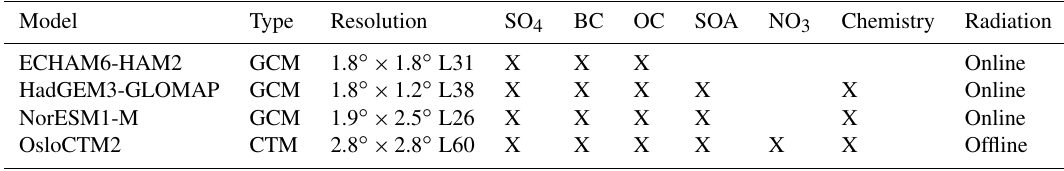
Table 2. List of models participating in the ECLIPSE radiative forcing simulations. Models are either general circulation models (GCM) or chemistry-transport models (CTM). Resolution indicates the horizontal resolution, in degrees, and the number of vertical levels. Crosses indicate which aerosol species are represented in each model, among sulfate (SO 4 ), black carbon (BC), organic carbon (OC), secondary organic aerosol (SOA), and nitrate (NO 3 ) aerosols. Chemistry indicates whether the model includes an interactive tropospheric ozone chem- istry scheme. Radiation indicates whether radiation calculations are done interactively (online) or offline from monthly distributions. Note that ozone radiative forcing calculations are done offline for all